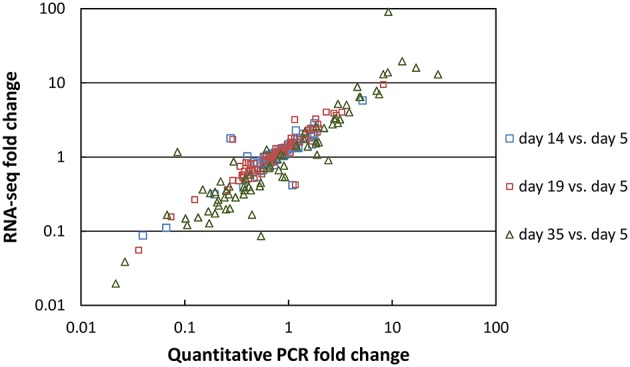
Correlation between RNA-seq and reverse transcription-quantitative PCR data. The fold changes vs. day 5 were calculated for 80 G. candidum genes.